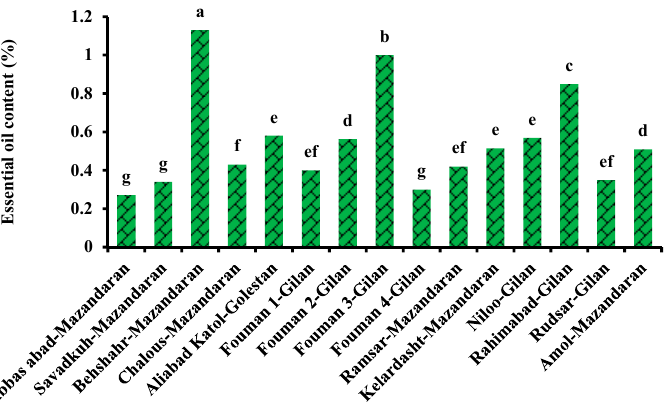
Figure 6. Essential oil concentrations of M. aquatica populations from the Hyrcanian hotspot of Iran. Different letters indicate a significant difference according to the LSD test at p < 0.05.